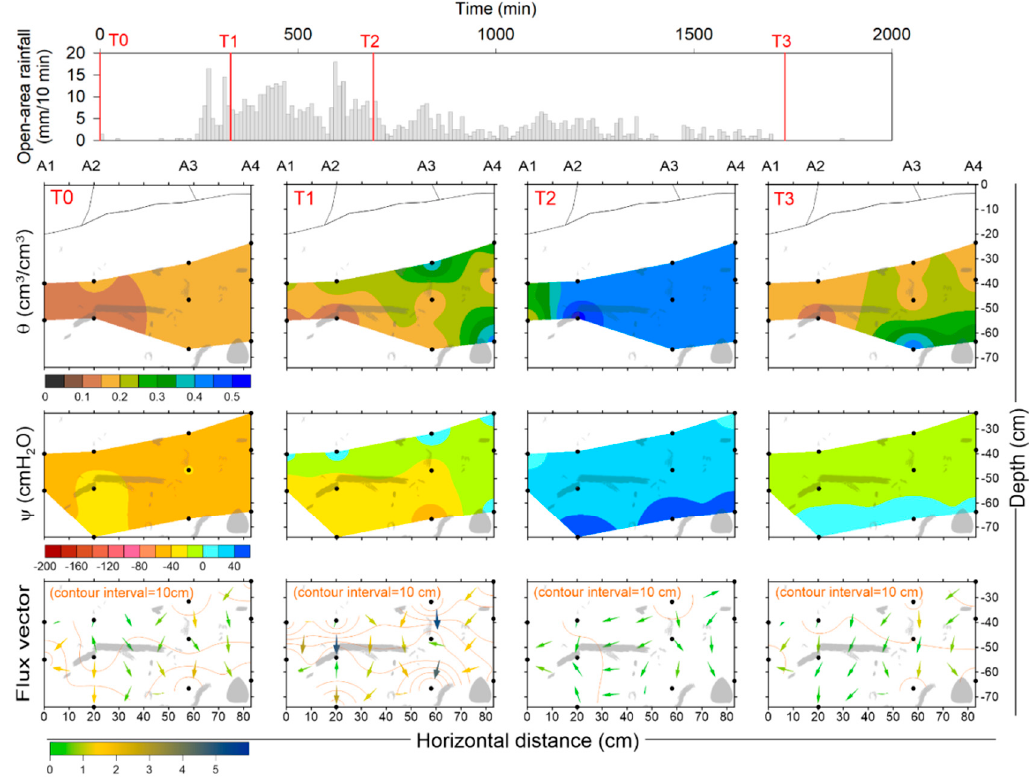
Figure 6. Spatial distributions of soil water content ( θ ), soil water potential ( ψ ), and flux vectors after 0 (T0), 330 (T1), 690 (T2), and 1730 (T3) min during the largest rainfall event in the observation period. Other details are as described for Figure 5.